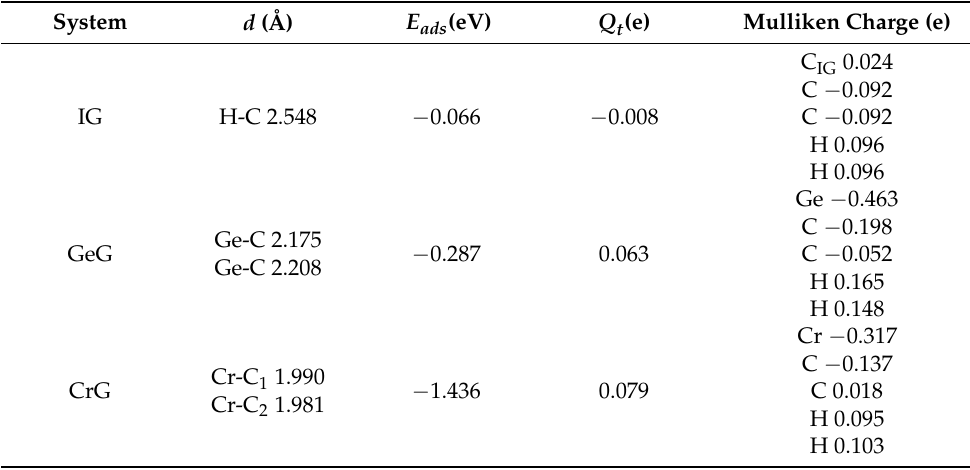
Table 4. The geometrical parameters of C 2 H 2 adsorption